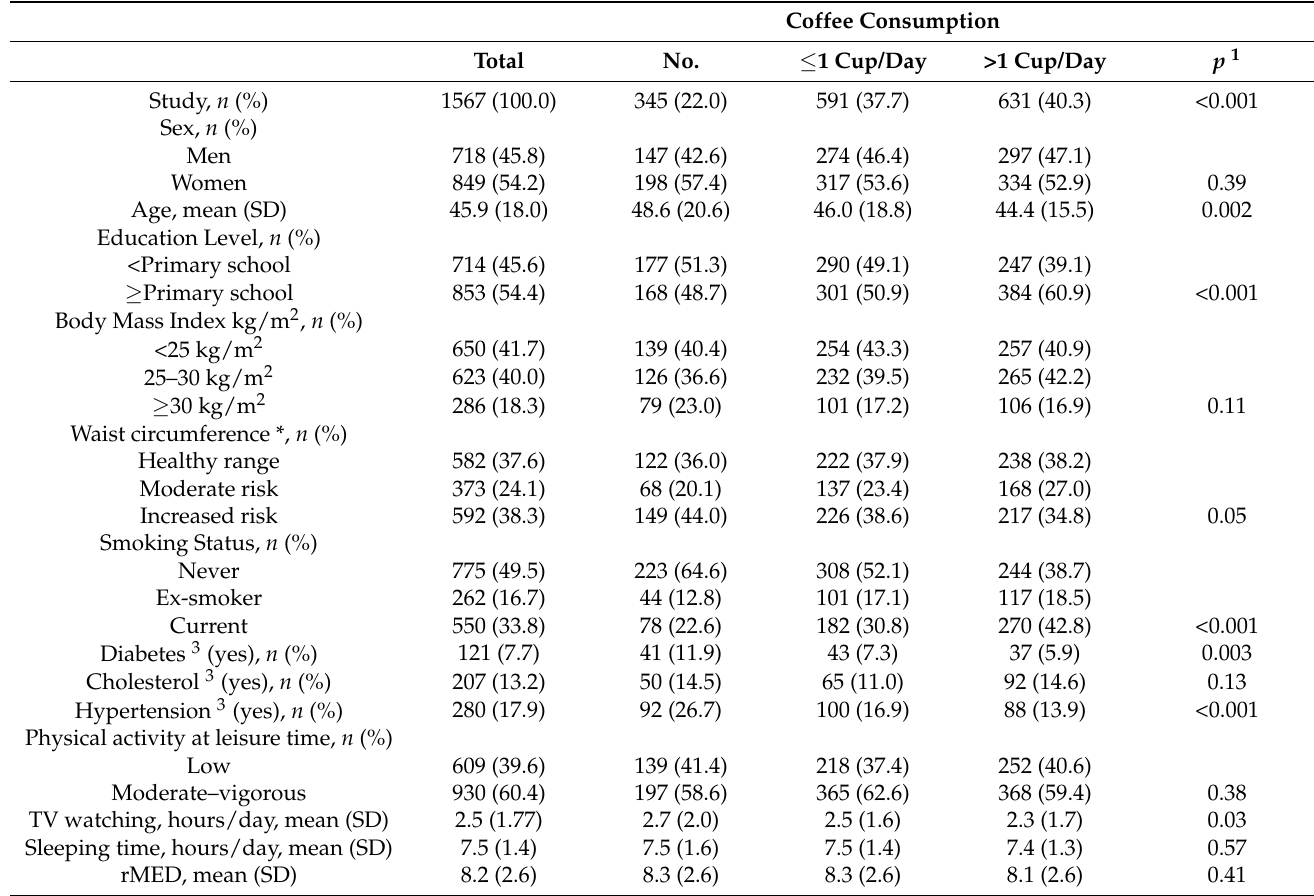
Table 1. Socio-demographic and lifestyle characteristics according to total coffee consumption among participants aged 20 years and above of the EUREYE-Spain and the Valencia Nutrition Study in Spain ( n =